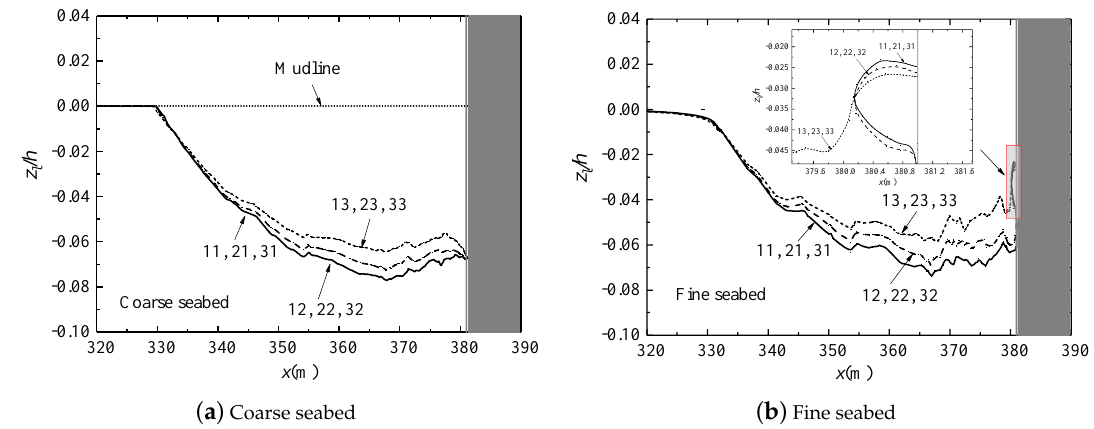
Figure 19. Liquefaction depth on the x – z plane, with y = 200 at t = 83.5 s, for various non-homogeneous anisotropic